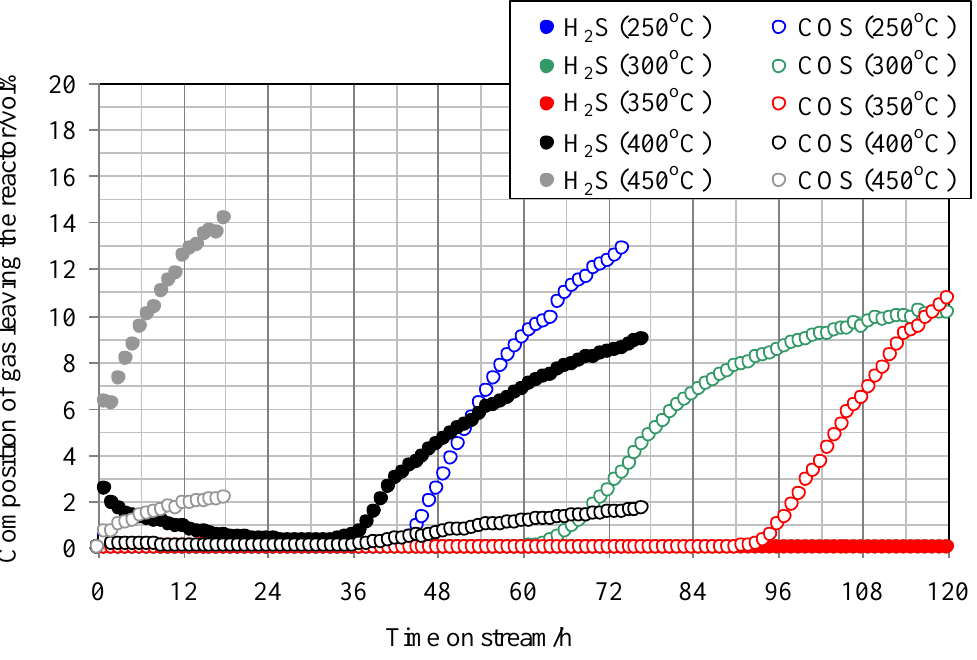
Figure 2. Breakthrough curves for COS using Fe0 at different temperatures. (Feed gas; CO: 46.1 vol%, H : 31.6 vol%, CH 2 N : 17.0 vol%, COS: 20 ppmv). Commercial activated carbon without modification is 2 denoted by